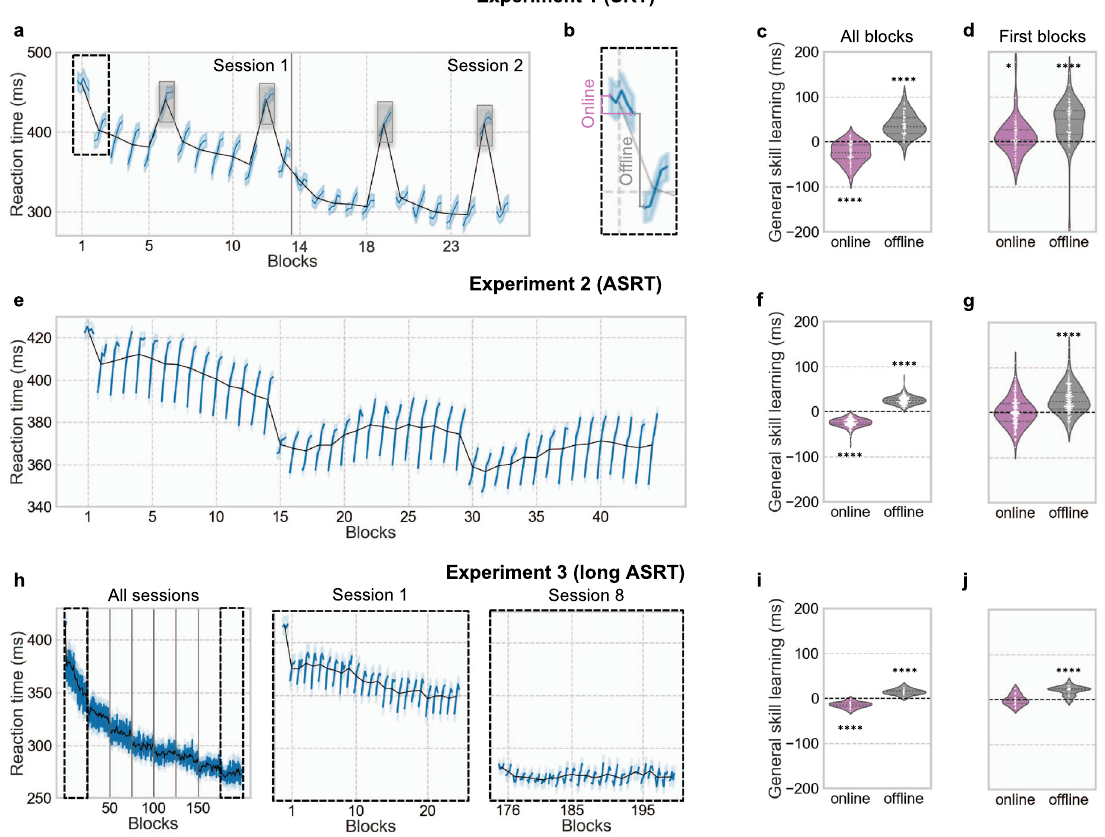
Fig. 2 General skill learning occurs during rest periods. a Average reaction time per block (black line) and per bin (blue line) for the Experiment 1 (SRT). Note that the random blocks in gray boxes were removed from analyses. b Depiction of online and of fl ine learning measurement. c Average online and of fl ine general skill learning across all blocks and d for only the fi rst block of both sessions for Experiment 1 (SRT). e Average reaction time per block (black line) and per bin (blue line) for Experiment 2 (ASRT). f Average online and of fl ine general skill learning across all blocks and g for only the fi rst block for Experiment 2 (ASRT). h Average reaction time per block (black line) and per bin (blue line) for Experiment 3 (long ASRT). For better visualization, a zoom-in for day 1 and day 8 is represented. i Average online and of fl ine general skill learning across all blocks and j for only the fi rst block of the 8 sessions for Experiment 3 (long ASRT). Signi fi cance is noted by a single asterisk (*) for p value <0.05 and four asterisks (****) for p value <0.0001. In violin plots, higher values mean greater learning. Error bars represents standard